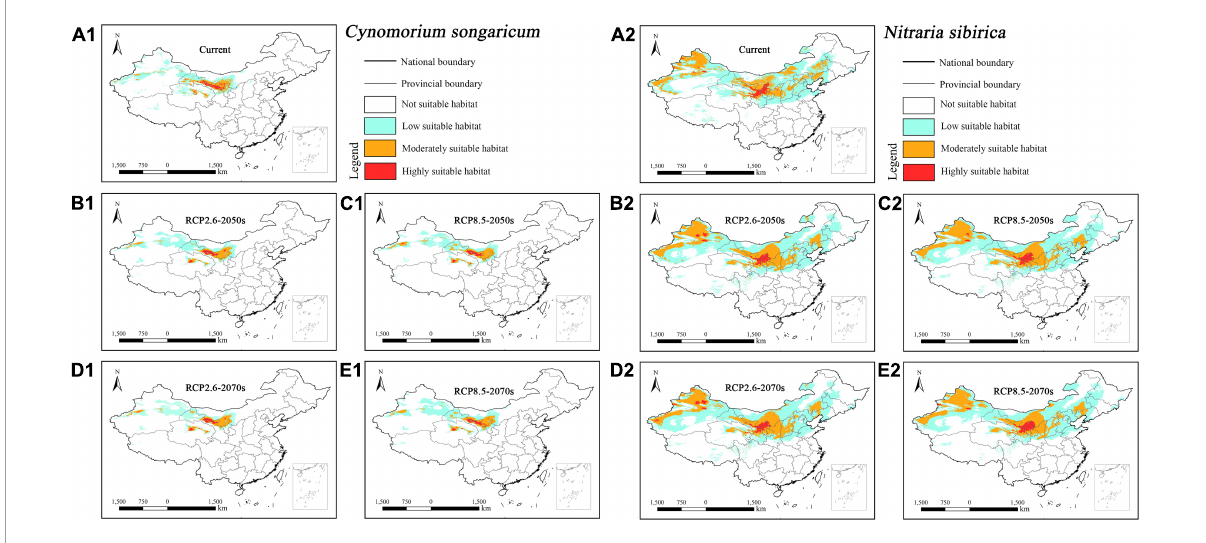
FIGURE3 Predicted suitable habitat distributions of Cynomorium songaricum (A1–E1) and its host Nitraria sibirica (A2–E2) under different climate scenarios in China.